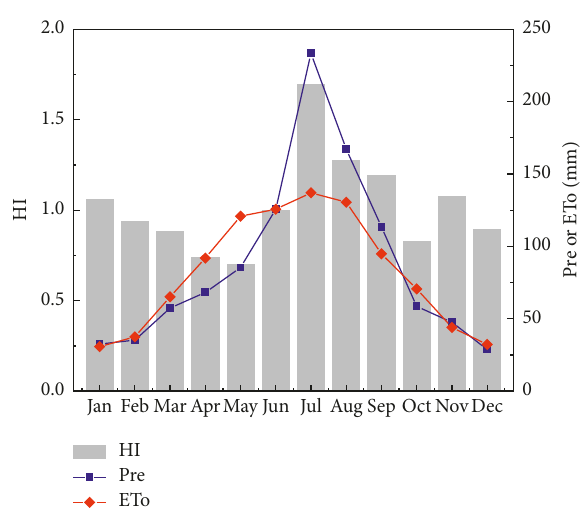
Figure 2: Variations in monthly humidity index (HI), reference evapotranspiration (ET o ), and precipitation